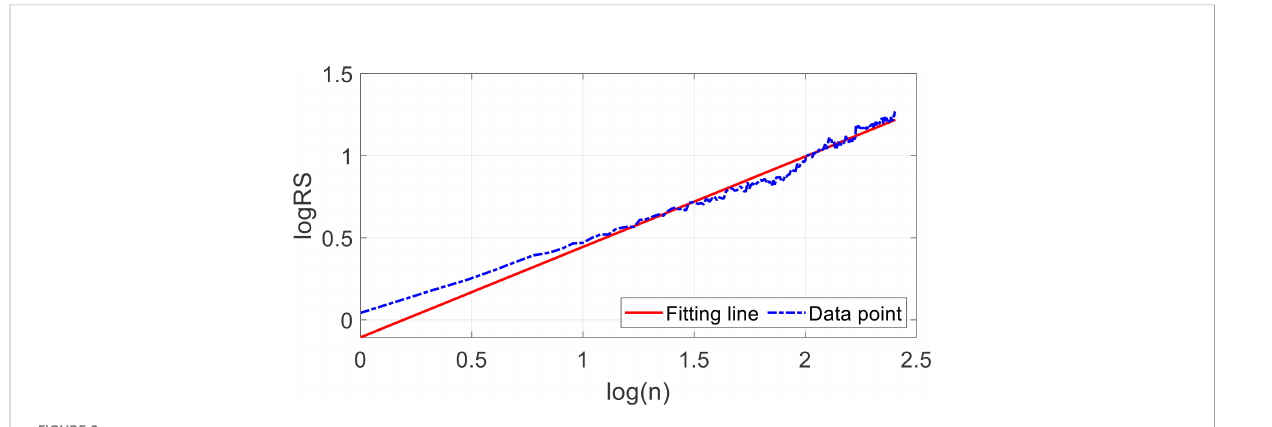
be detected at all in the STFT diagram.